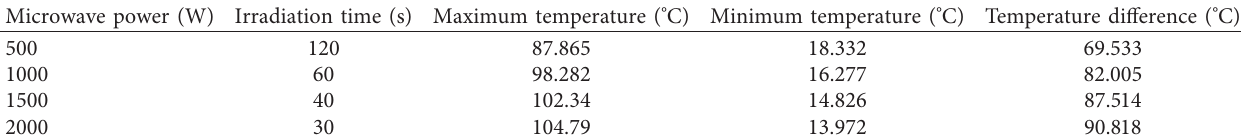
Table 6: Variation trend of temperature under different microwave power.